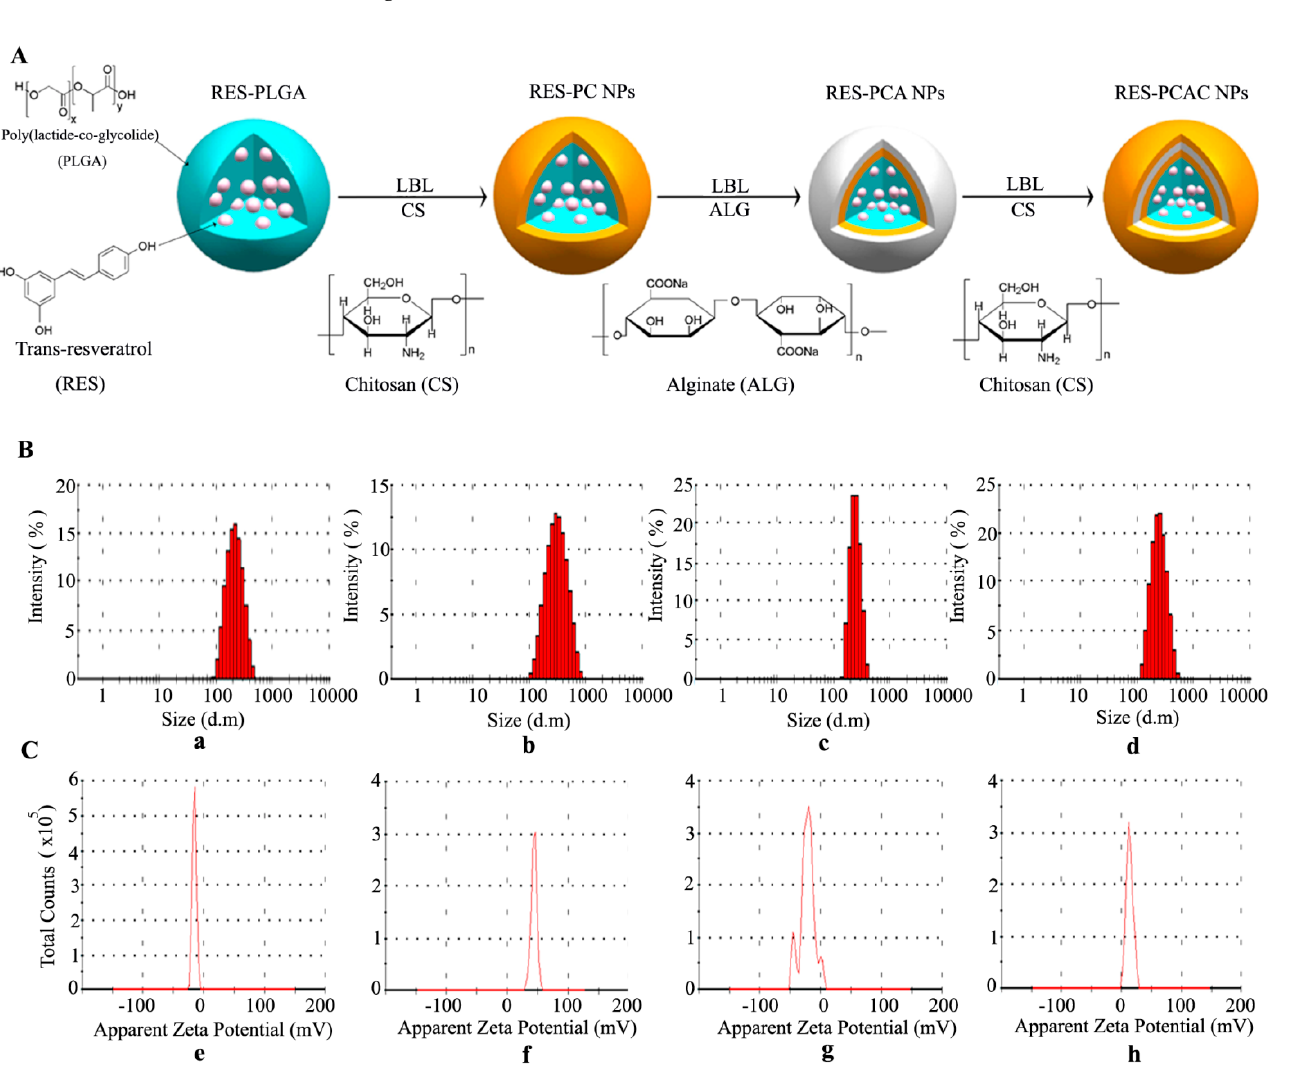
Figure 1. Preparation and characterization of RES-PCAC-NPs. Preparation of RES-PCAC-NPs by LBL process ( A ). The average particle size ( B ). Zeta potential ( C ) of PLGA-NPs ( a , e ), PC-NPs ( b , f ), PCA-NPs ( c , g ), PCAC-NPs ( d , h ) detected by Zetasizer Nano ZS.